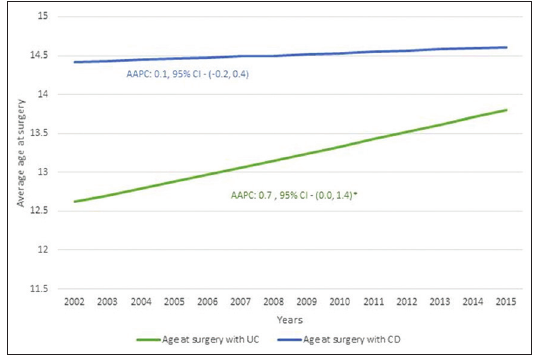
Supplemental Figure 5: Average age at surgery for Crohn’s disease (CD) and ulcerative colitis (UC) patients from 2002-2015 AAPC= Average Annual Percent Change. *p≤0.05